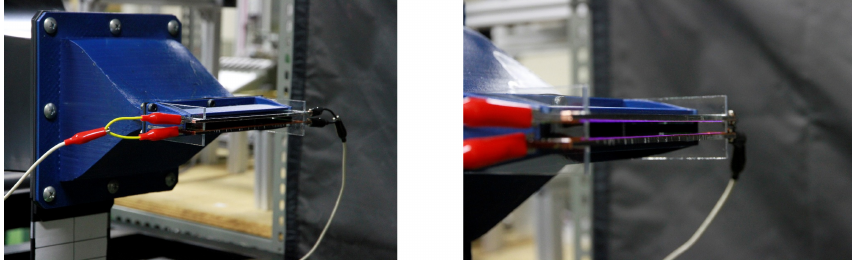
Figure 9. Full installation of an operating nozzle and plasma actuators onto the wind tunnel.